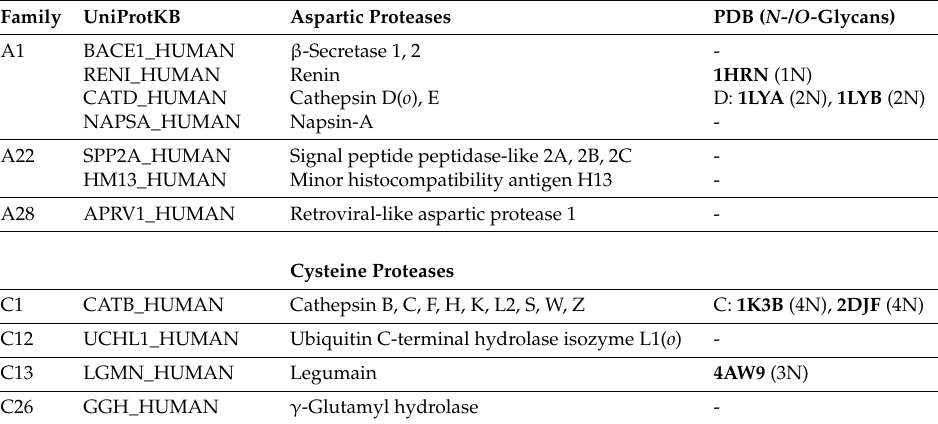
Table 1. Human aspartic and cysteine proteases with experimentally confirmed or predicted glycosylation sites ( O -glycosylation indicated in parentheses as “ o ”). MEROPS families are A1,